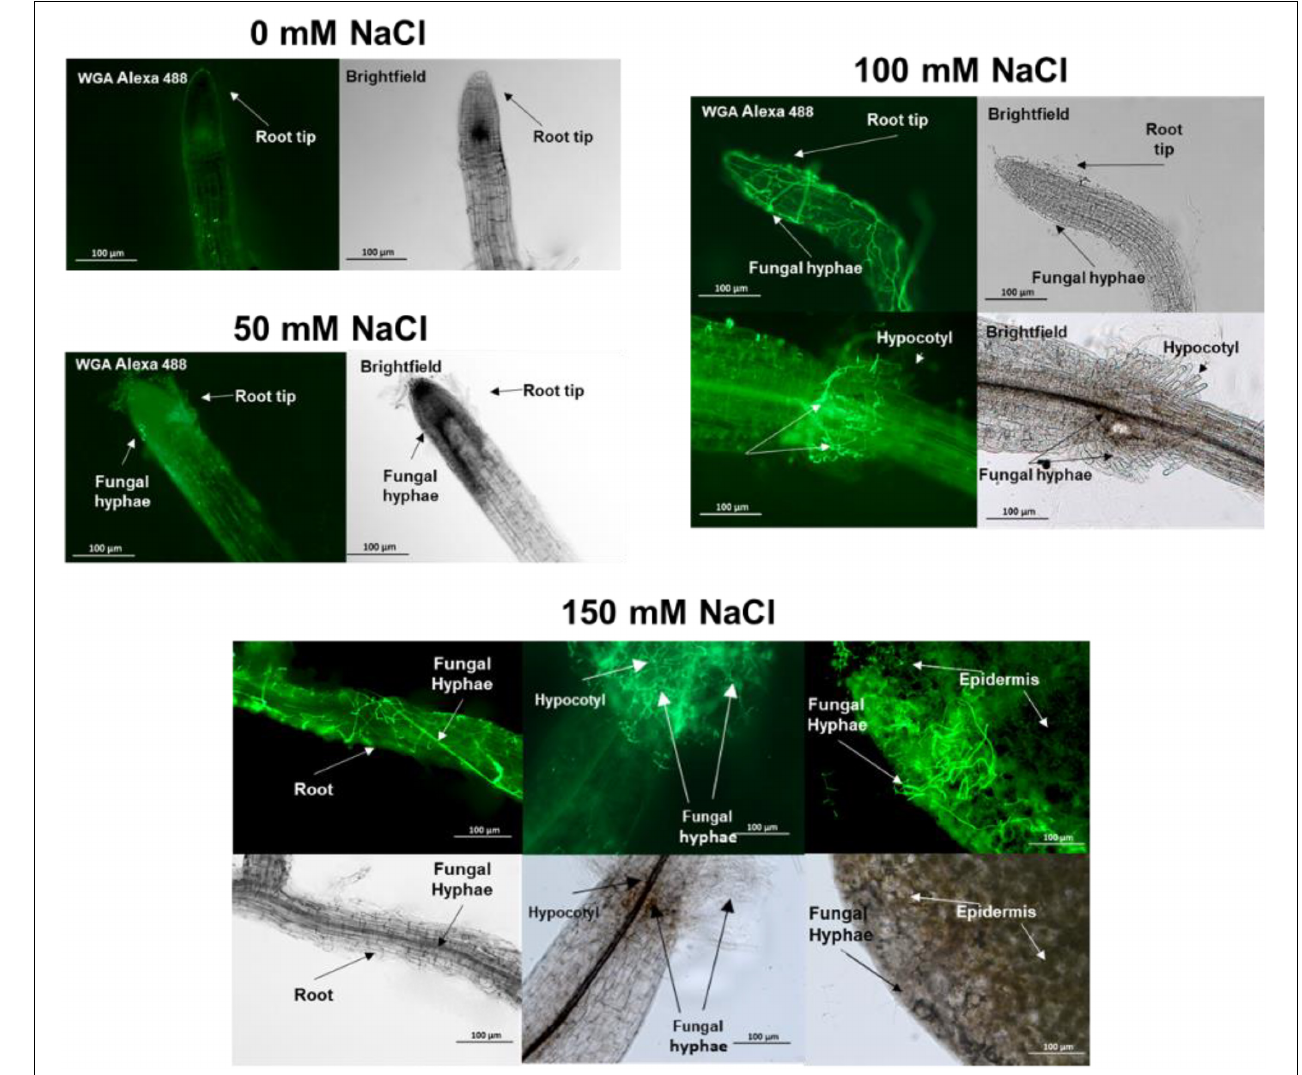
FIGURE 4 | Trichoderma spp. hyphae in the root, hypocotyl and leaf of 15 day-old Arabidopsis seedlings colonized by the fungus since 10 days. Cocultivation occurred on media with 0–150 mM